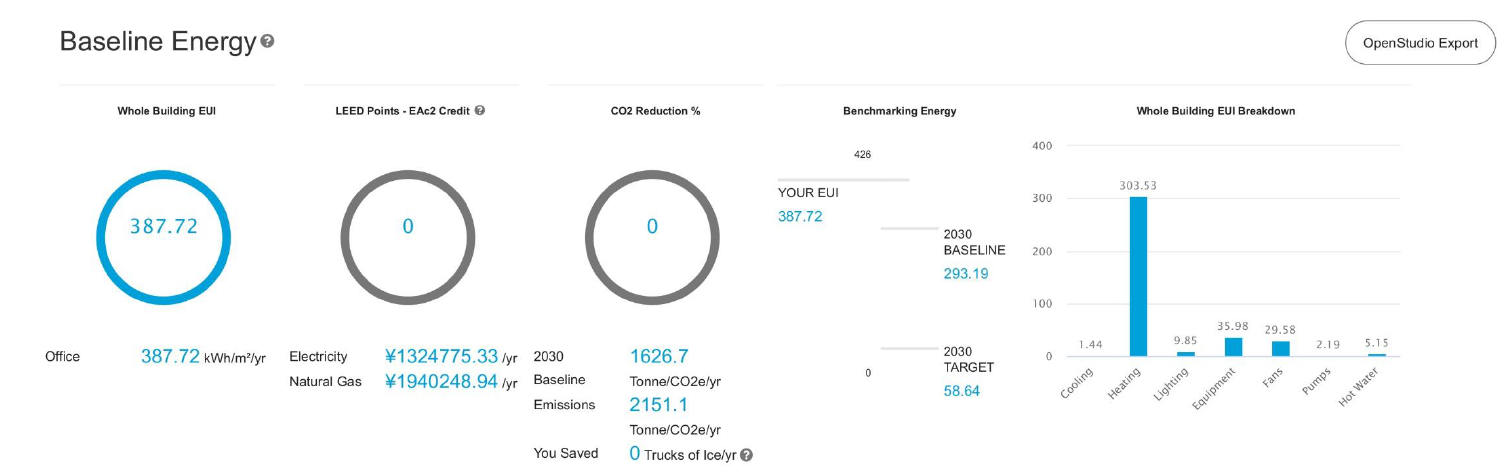
Figure A26. Zone 5-B Lanzhou, Gansu (post-COVID-19 78% scenario).